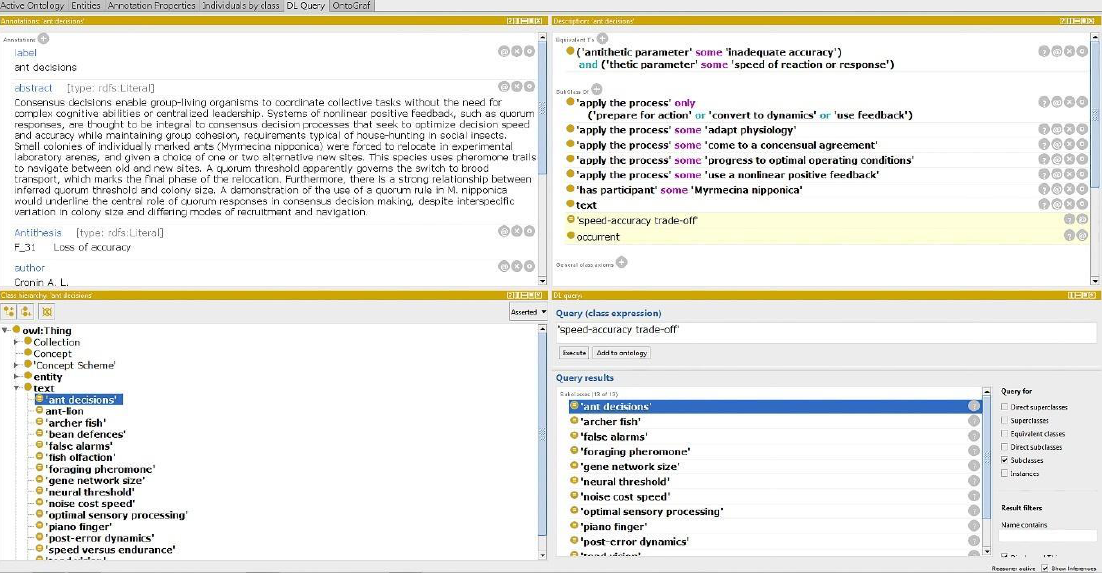
Figure 3. Results of querying the BMO for speed/accuracy trade-off within Protégé. Bottom right image shows ‘DL query’ tab with ‘Query results’, a list of Biological Models as potential solutions. ‘Ant decision’ is selected, thus information is provided in the description tab which outlines IPs attached to that specific biology strategy. The top left tab, ‘Annotations’, provides an abstract of the biological text containing the specific biological strategy identified. Note: to ensure this is the information retrieved from the query the user must know how to retrieve these specific tabs.